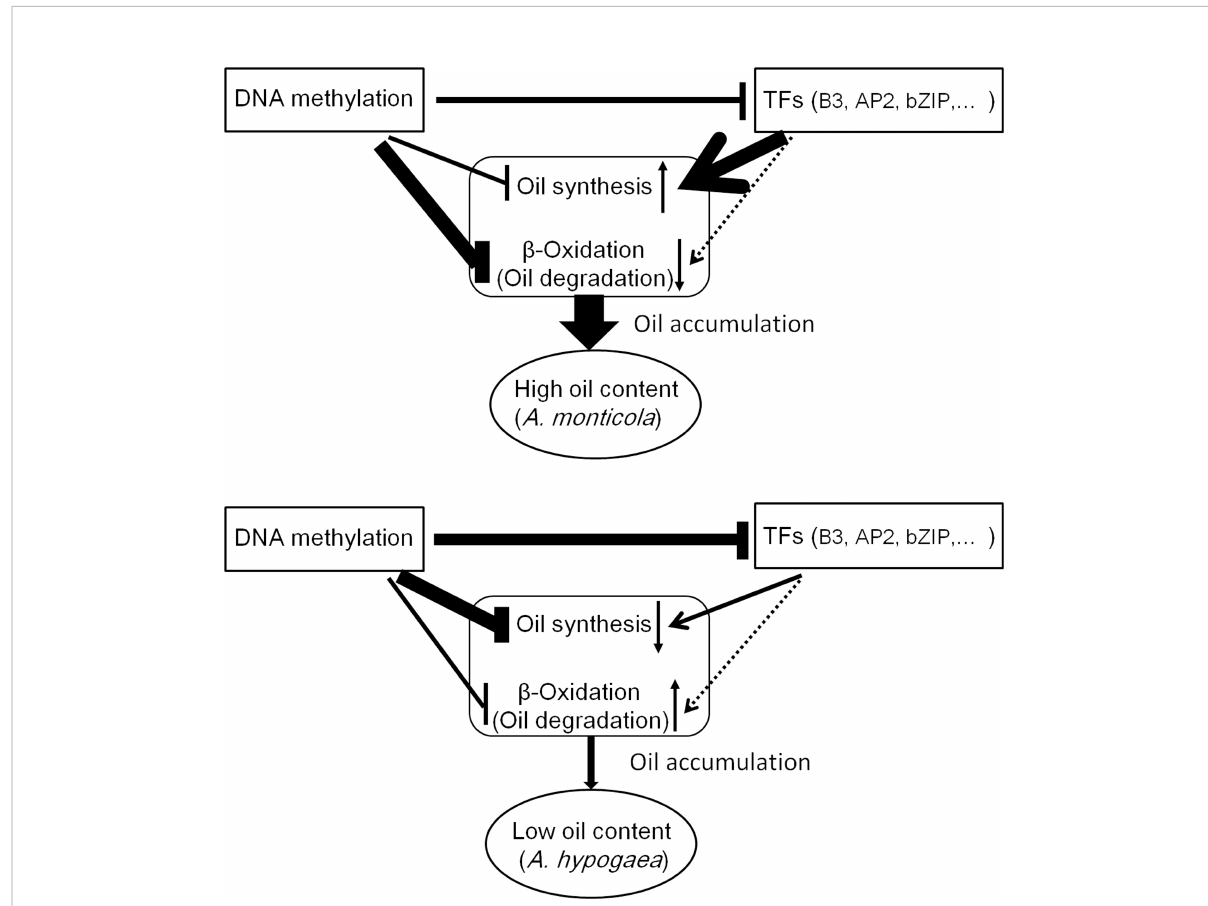
FIGURE 9 A regulatory model of lipid accumulation in peanut seed. Compared to A. hypogaea , A. monticola activated the transcription of genes involved in oil synthesis and depressed the transcription of genes involved in b -oxidation via DNA methylation and TFs in seed. Thus, DNA methylation and TFs coordinately tuning the expression of genes contribute to high oil accumulation in A. monticola